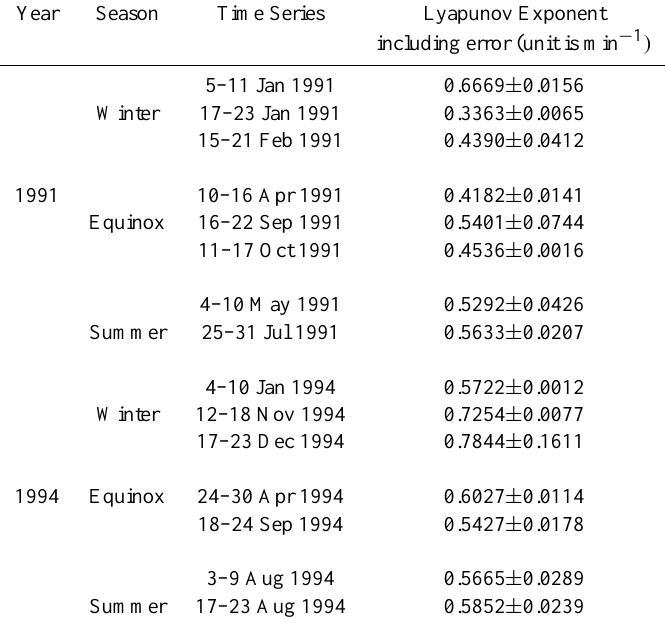
Table 2. Values of Lyapunov exponent for time series of AE index during quiet